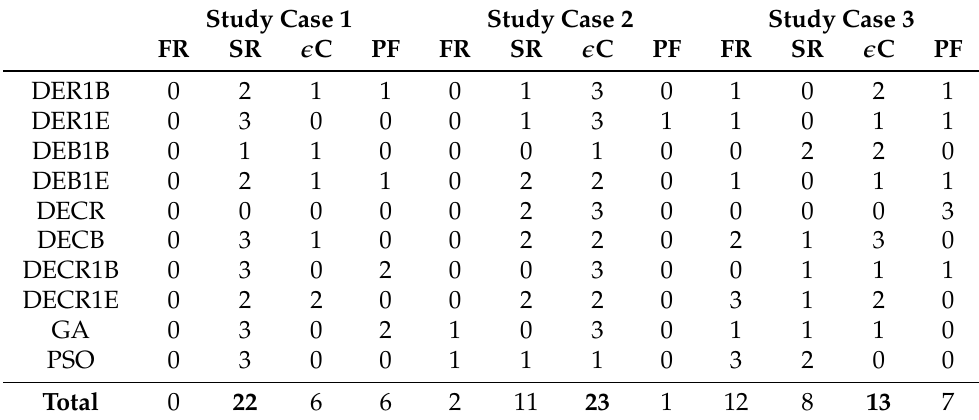
Table 11. Number of winners in the PR metric by using the multi comparative